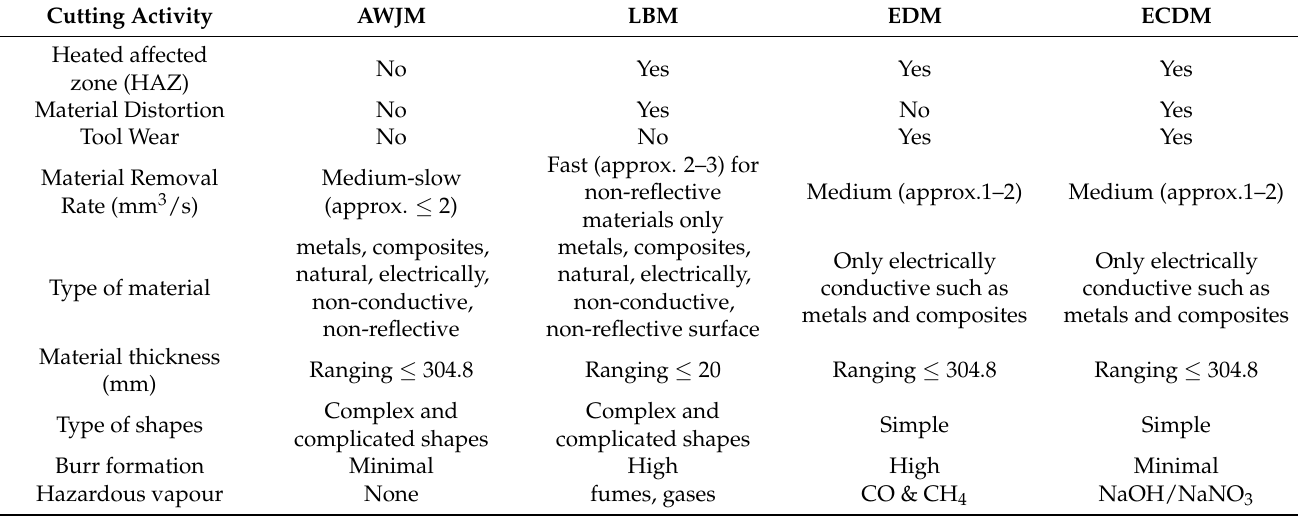
Table 1. Comparison of non-conventional cutting technologies